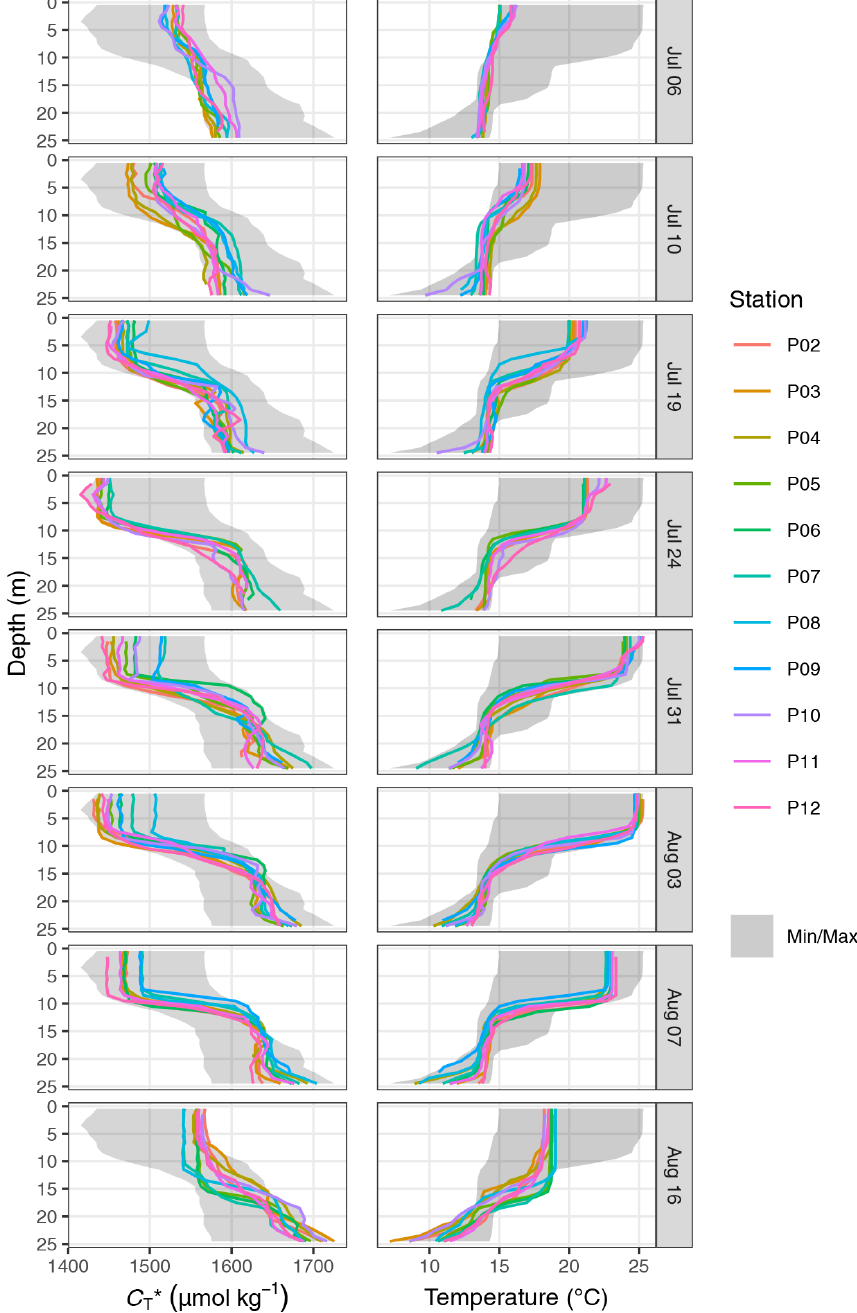
Figure C3. Individual profiles of C ∗ (left panels) and temperature (right) displayed separately for each cruise day (rows) and station (colour). T Grey ribbons indicate the minimum and maximum values observed over the entire study